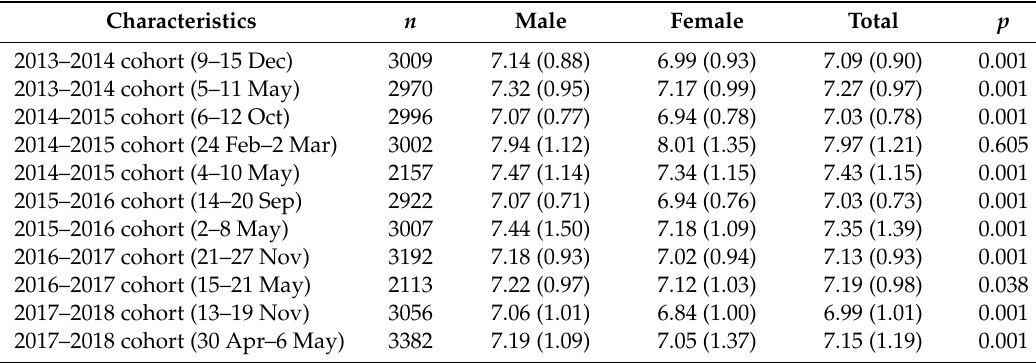
Table 2. Mean hours of sleep in the last week (h / week) ( n = 31,806).